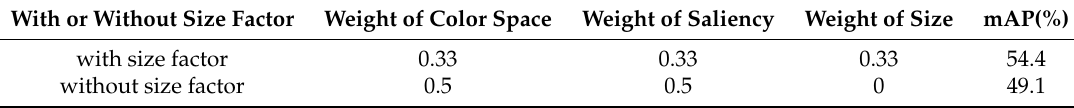
Table 2. Recognition accuracies with or without region size factor (%).